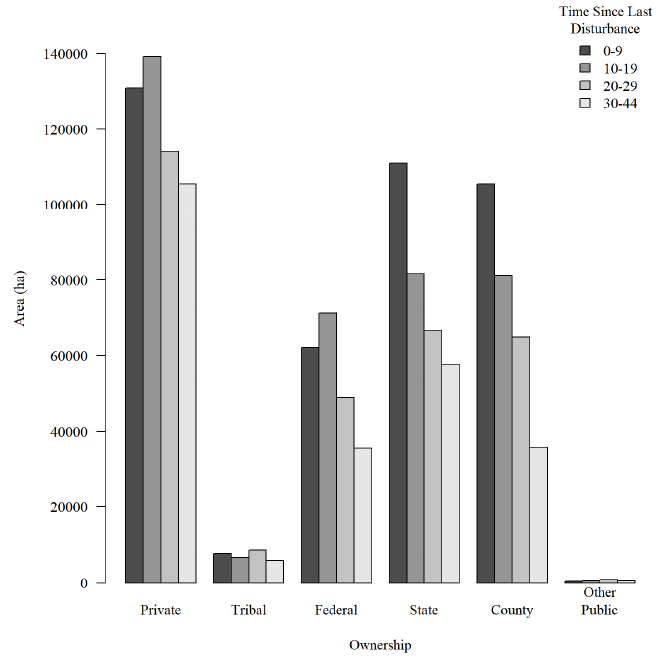
Figure 5. Time since last disturbance class areas summarized by land ownerships.